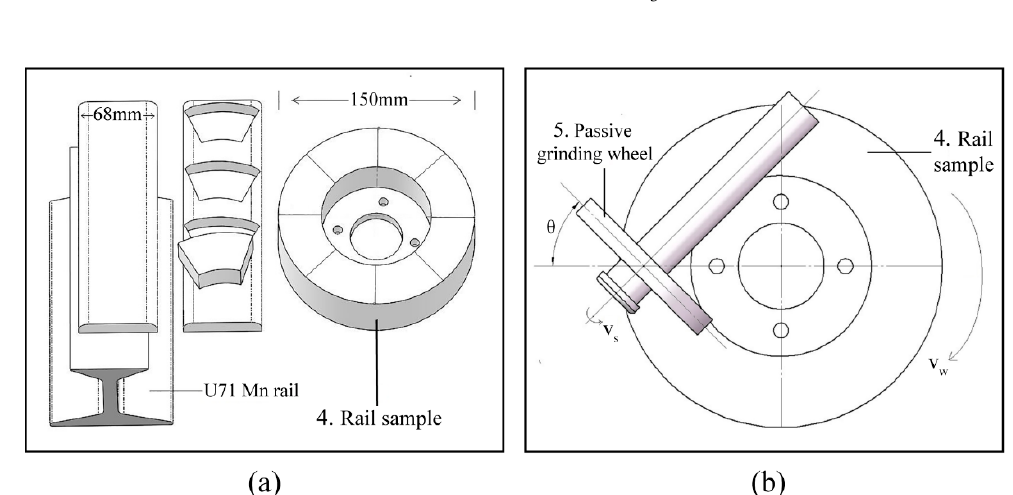
Figure 4. ( a ) Preparation and morphology of rail sample, ( b ) passive grinding process.